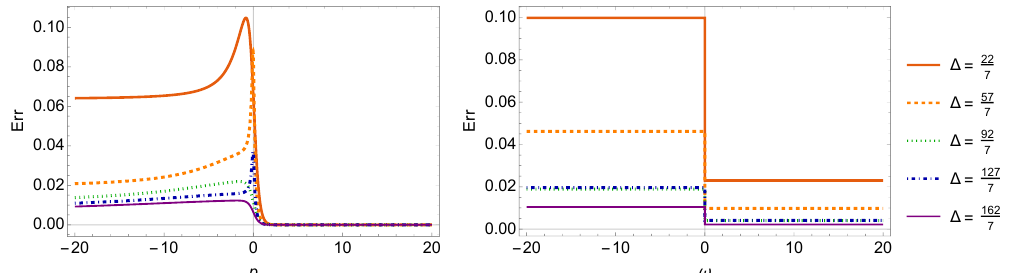
Figure 14: The error function of the WKB formula (2.17), Err (D.1), for an extremal- BTZ geometry as a function of ω , p and ∆ . The graph on the left gives Err as a function of p for different values of ∆ and for ω = 1 / 2 and r the right gives Err as a function of ω for the same values of ∆ and for p = 1 / 2 and = r H